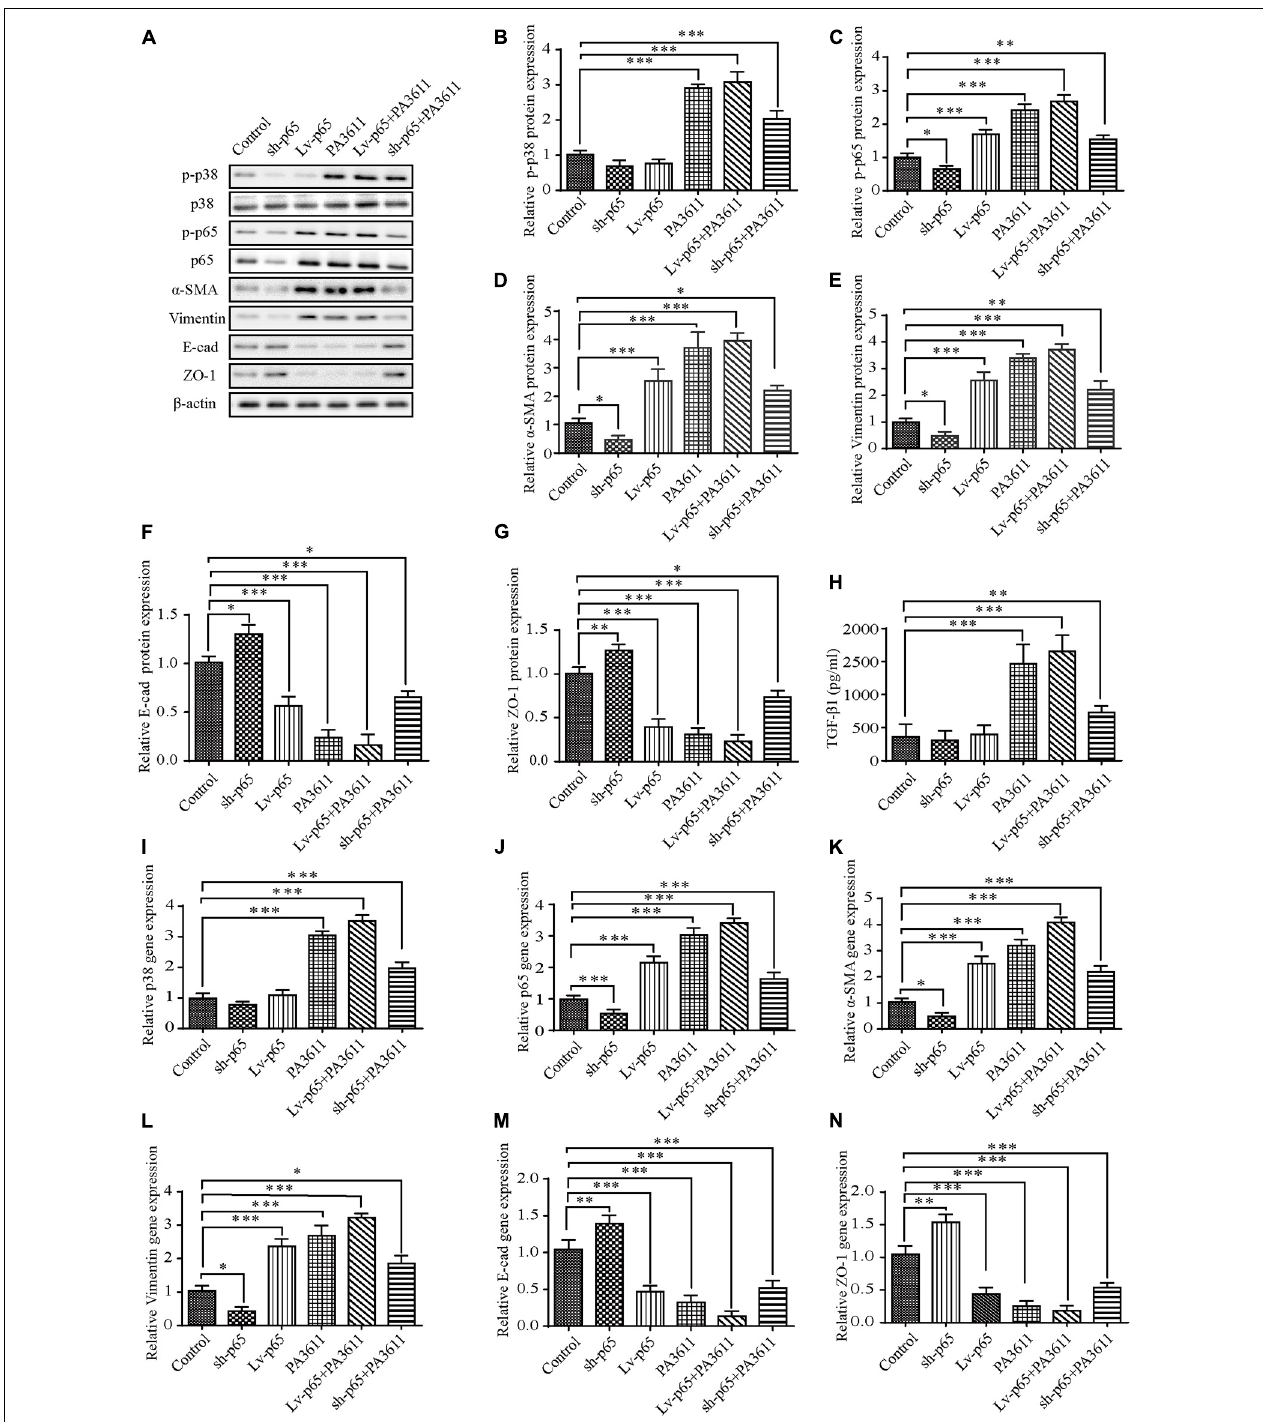
FIGURE 3 | Effects of p65 overexpression or knockdown on the expression of TGF- β 1, p38 phosphorylation and the expression of EMT-related markers. 16HBE14o- and RTE cells were transfected with a control vector (indicated as blank), a p65 overexpression vector (indicated as p65), or a specific siRNA directed against p65 (indicated as sh-p65). Twenty-four hours post-transfection, cells were treated with PBS (negative control) or PA3611 (10 µ g/mL) for another 48 h. Then, cells were collected to examine the gene and protein expression of p38, p65 and EMT-related markers (A–G,I–N) . Cell culture supernatants were collected for TGF- β 1 level evaluation by enzyme-linked immunosorbent assay (H) . The results are representative of three independent experiments. The data are presented as the mean ± SD. ∗ P < 0.05, ∗∗ P < 0.01, ∗∗∗ P < 0.001, vs. the control group.